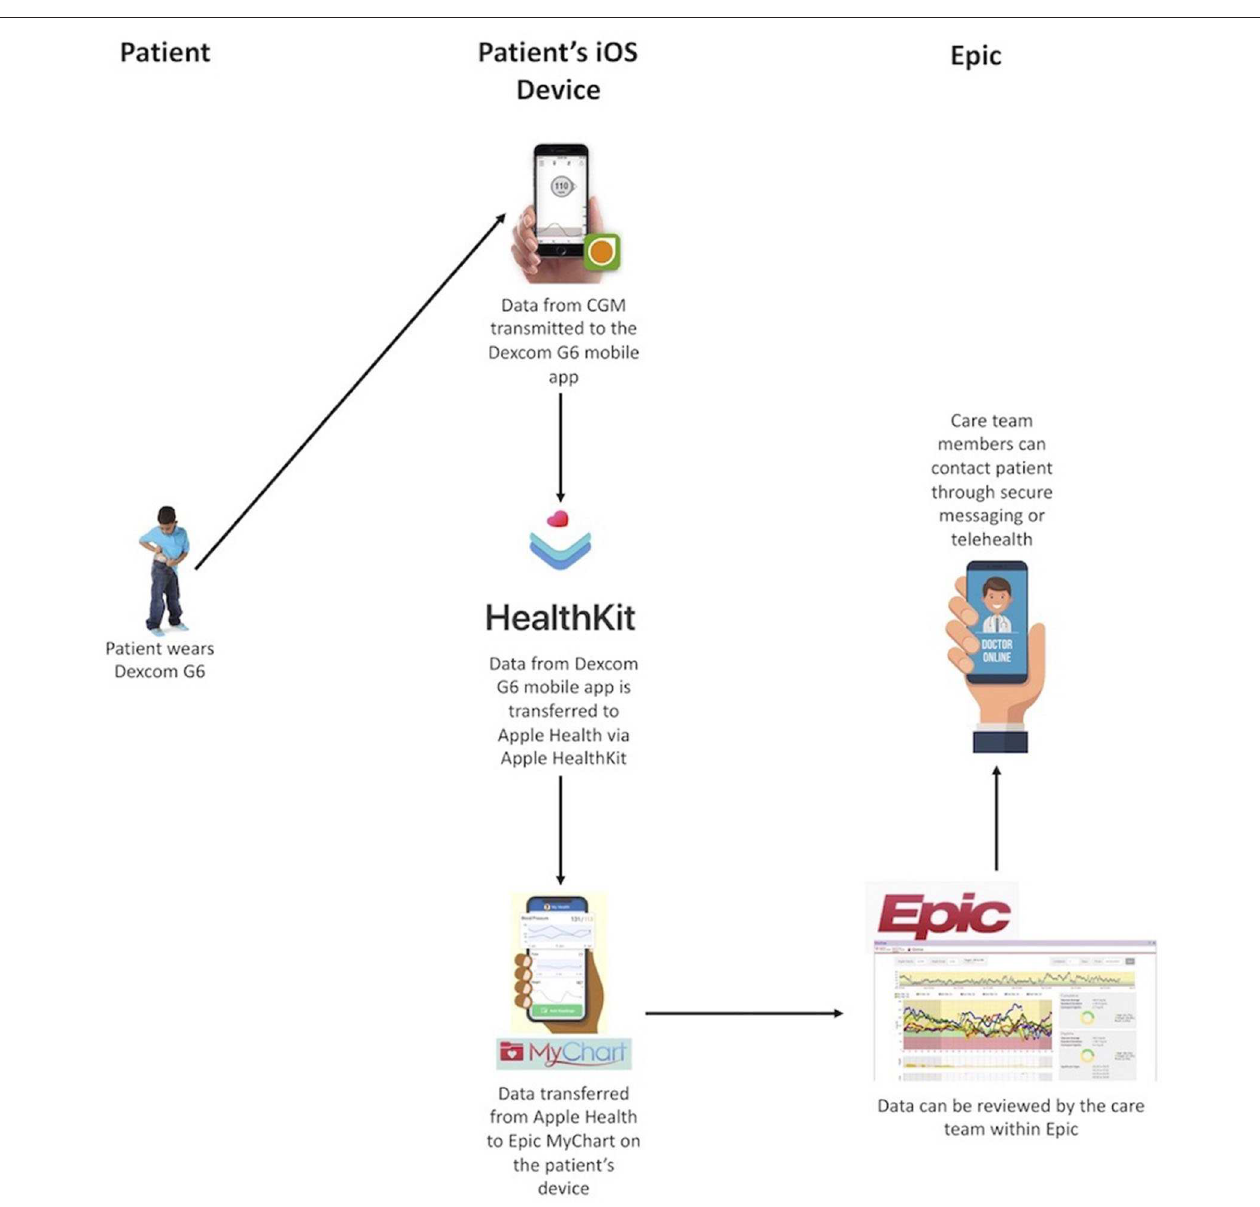
FIGURE 2 | Integration of Dexcom CGM data into the electronic health